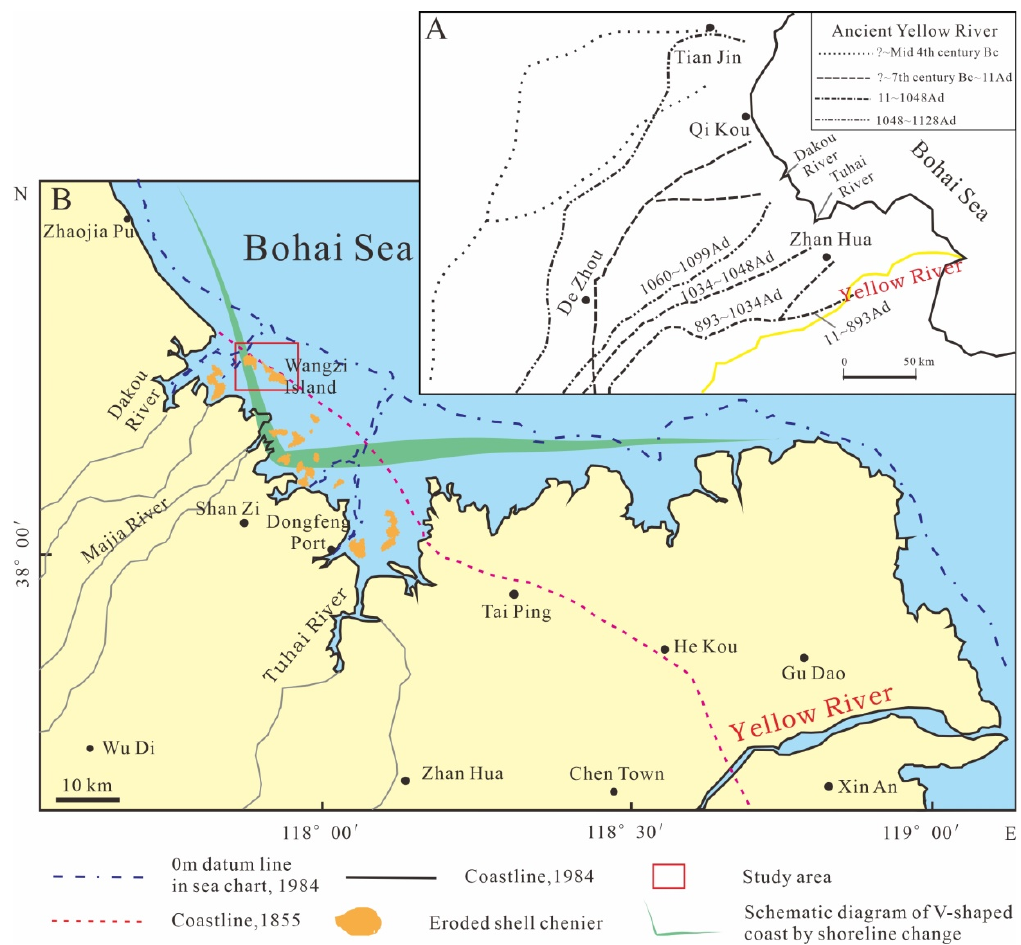
Figure 1. ( A ): Location of the Yellow River mouth before 1128; ( B ): The coastlines from the Dakou River mouth to the Tuhai River mouth in 1855 and 1984 (According to references [25–27]).